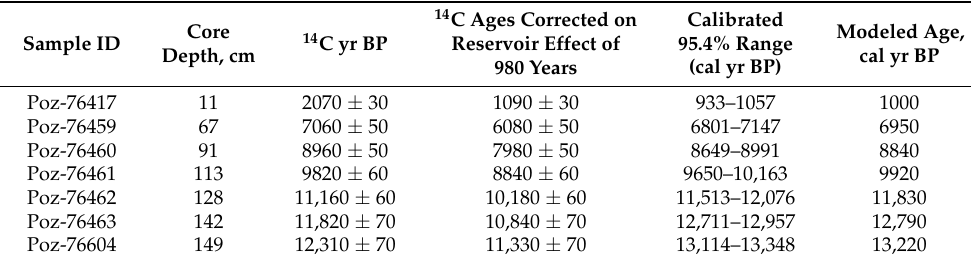
Table 1. AMS 14C dates and calibrated ages for the Lake Kaskadnoe-1 core. Calibration was performed using R package version 2.5.0. https://CRAN.R-project.org/package=clam (accessed on 27 February 2023)